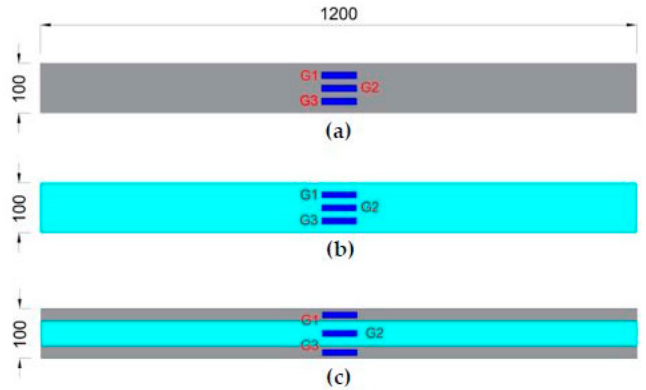
Figure 2. Position of strain gauges for flexure: ( a ) Control samples, ( b ) B1, B2 ( c ) B3, B4, B5 and B6.